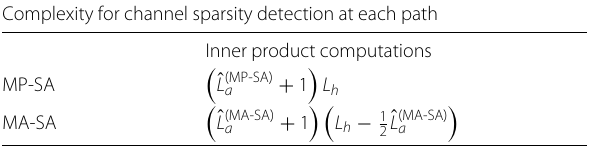
Table 1 Computational complexity of the MP-SA and MA-SA